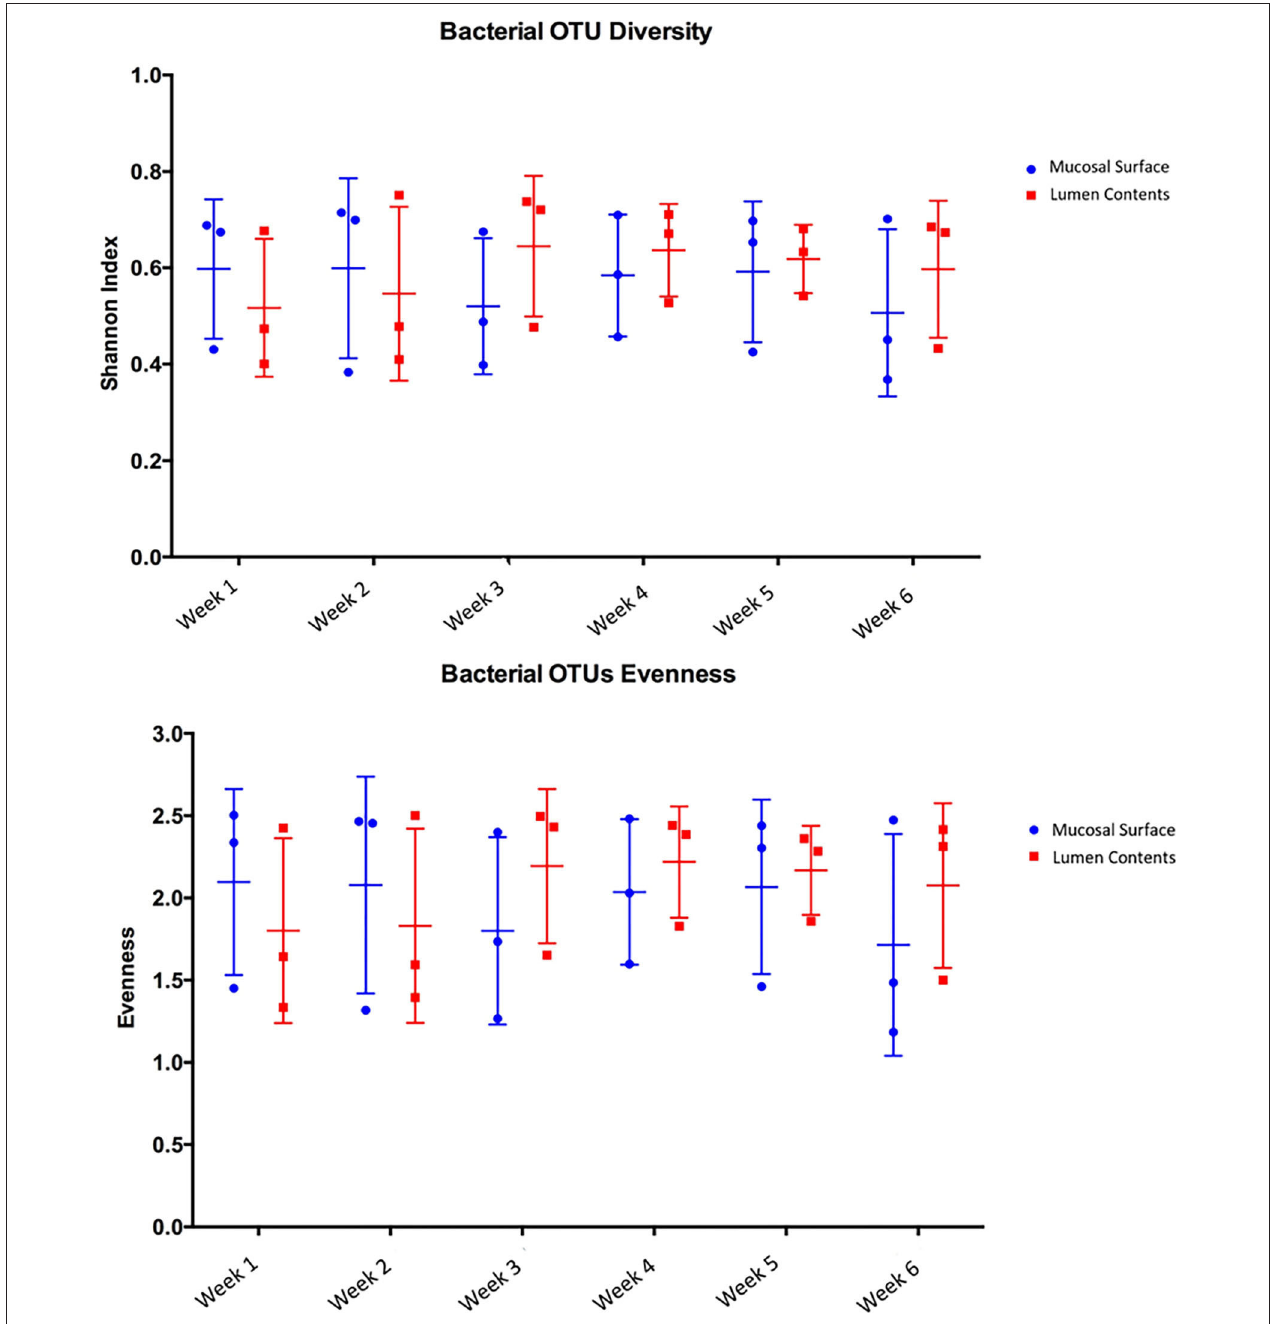
FIGURE 2 | Comparison of bacterial OTU’s Shannon index diversity and Pielou’s evenness for the mucosal surface and lumen contents for each week sampled.